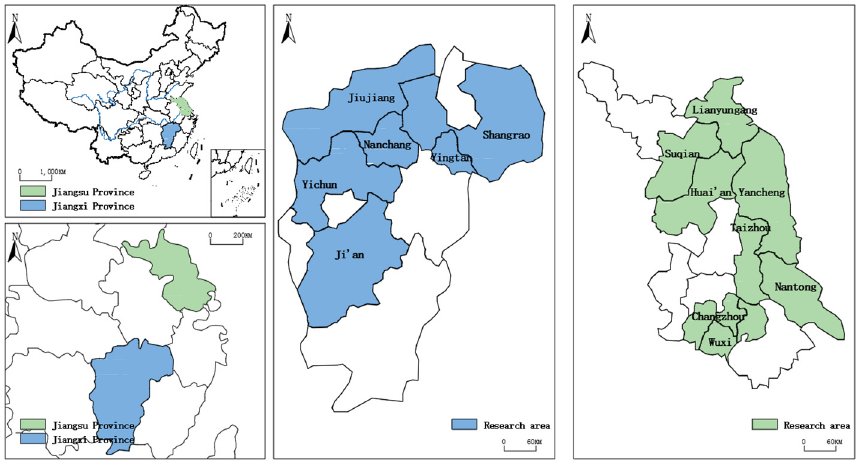
Figure 2. The Geographical Distribution of the Sampled Large-Scale Grain